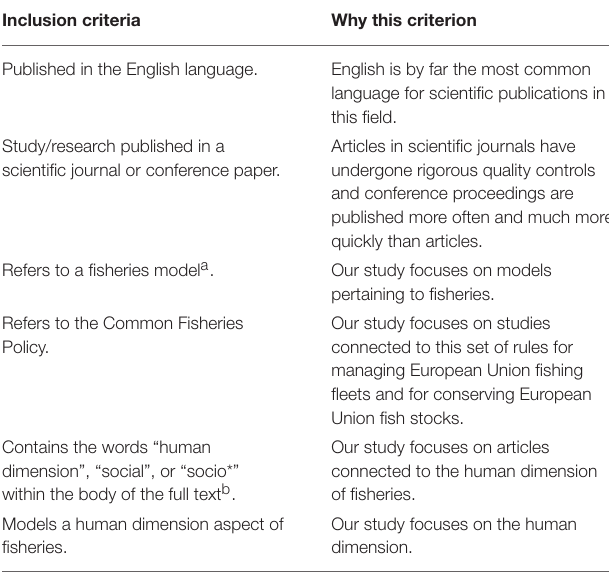
TABLE 1 | Inclusion criteria used to select publications for the systematic literature review of modeling the human dimension in fisheries models. Inclusion